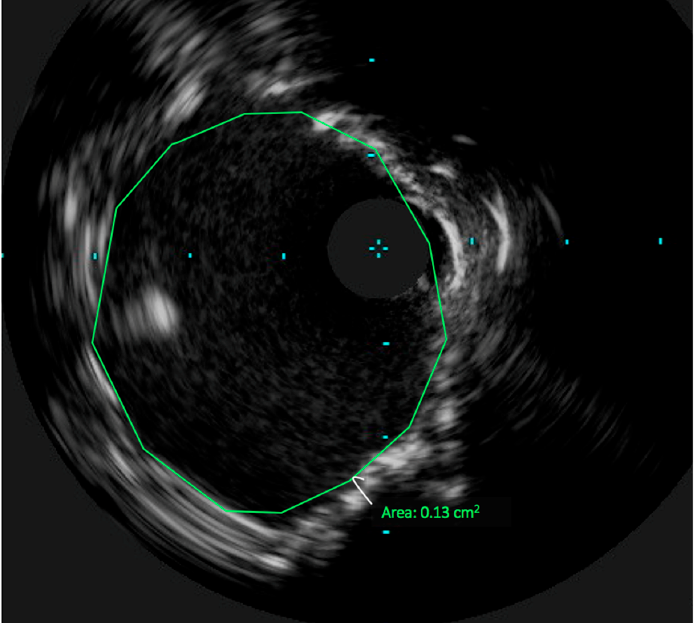
Figure 3. Post-PCI of the LMCA. IVUS of the LMCA after PCI with a 3.5 × 15 mm Resolute Onyx DES which dilated with a 4.0 mm noncompliant balloon. The minimal luminal area measures to 13 mm 2 . The CFX guidewire is just emerging into the LMCA lumen at 9 o’clock, which suggests that this image is in the distal LMCA. PCI: percutaneous coronary intervention. CFX: Left Circumflex Artery.